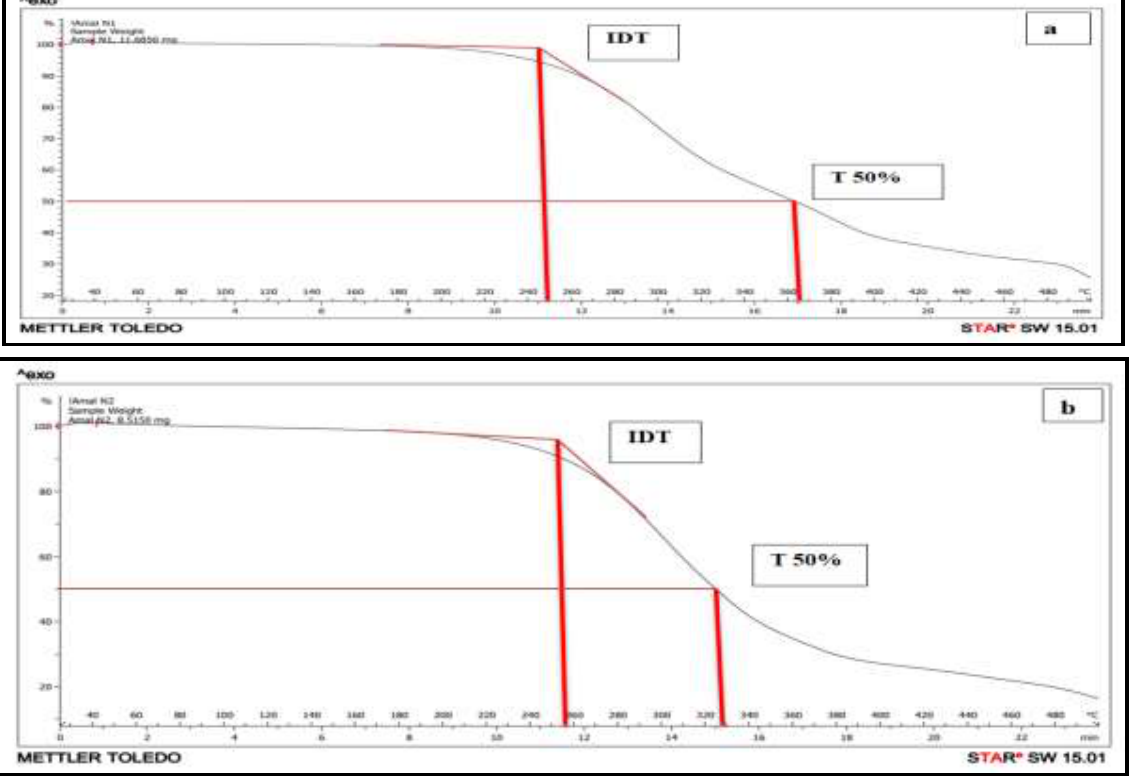
Figure 9. TGA of N1 co-crystal (a) and TGA of N2 co-crystal